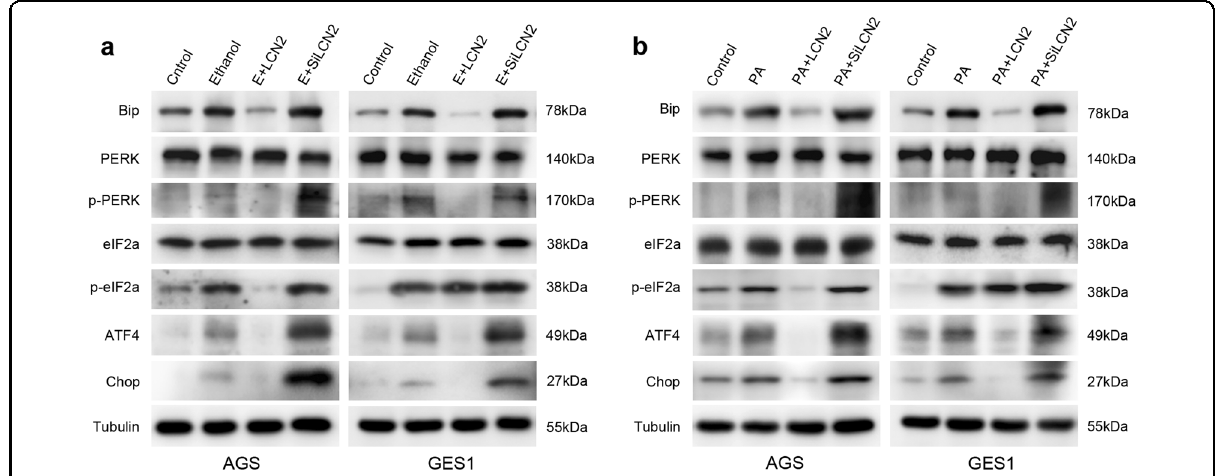
Fig. 6 LCN2 inhibits endoplasmic reticulum stress-mediated apoptosis signaling. a In ethanol damage model, western blot analysis of phosphorylated (p-) or total PERK, eIF2 α and Bip, ATF4, Chop. Tubulin was used as a loading control. b In palmitic acid damage model, western blot analysis of phosphorylated (p-) or total PERK, eIF2 α and Bip, ATF4, Chop. Tubulin was used as a loading